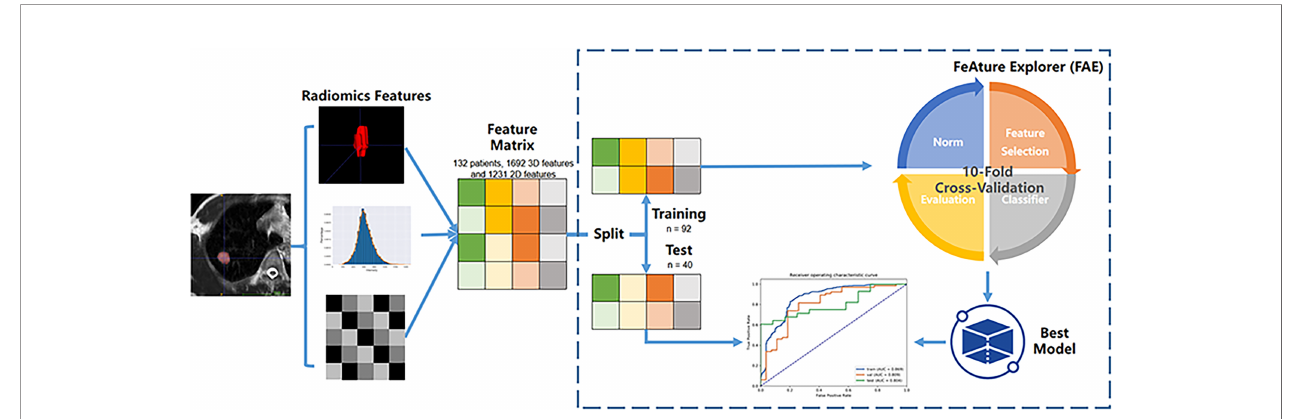
FIGURE 2 | Flow chart for the data processing.